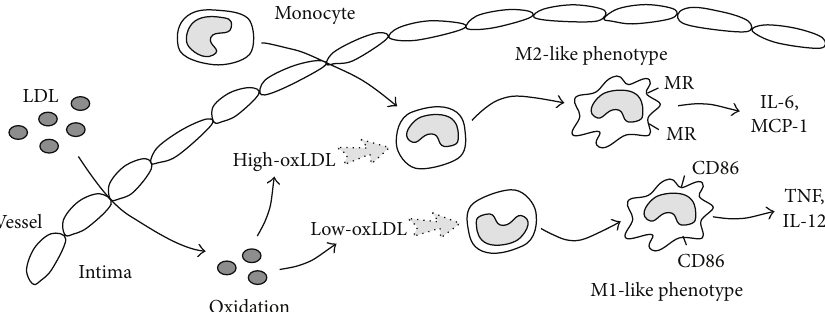
Figure 6: Graphical summary of monocyte differentiation into M1 or M2 macrophages by differentially oxidized LDL.